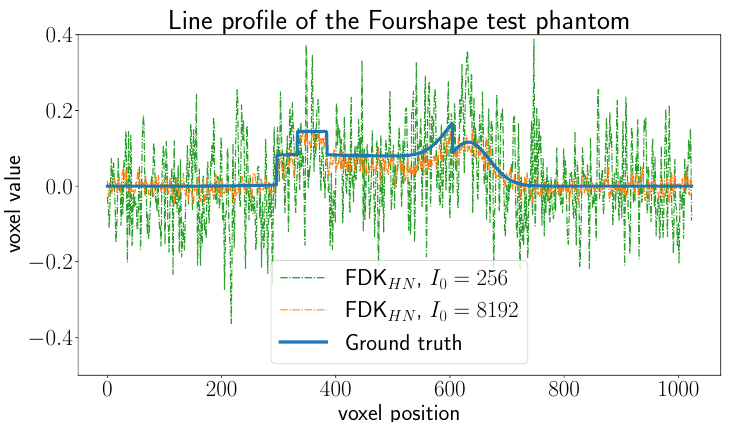
Figure 7. Line profile through the center of the z = 0 slice of the Fourshape test phantom. We show the ground truth profile, the profile of the FDK reconstruction with lowest emitted photon count I 0 = 256, and the profile of the FDK reconstruction with the highest emitted photon count I 0 = 8196.